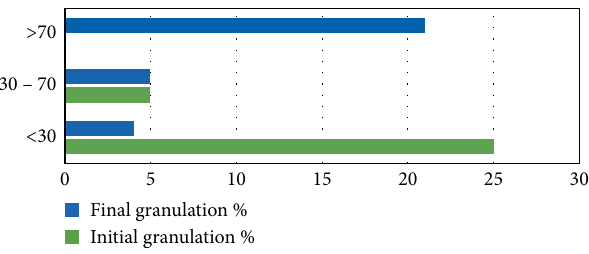
Figure 7: Comparison granulation % at start and end of treatment.